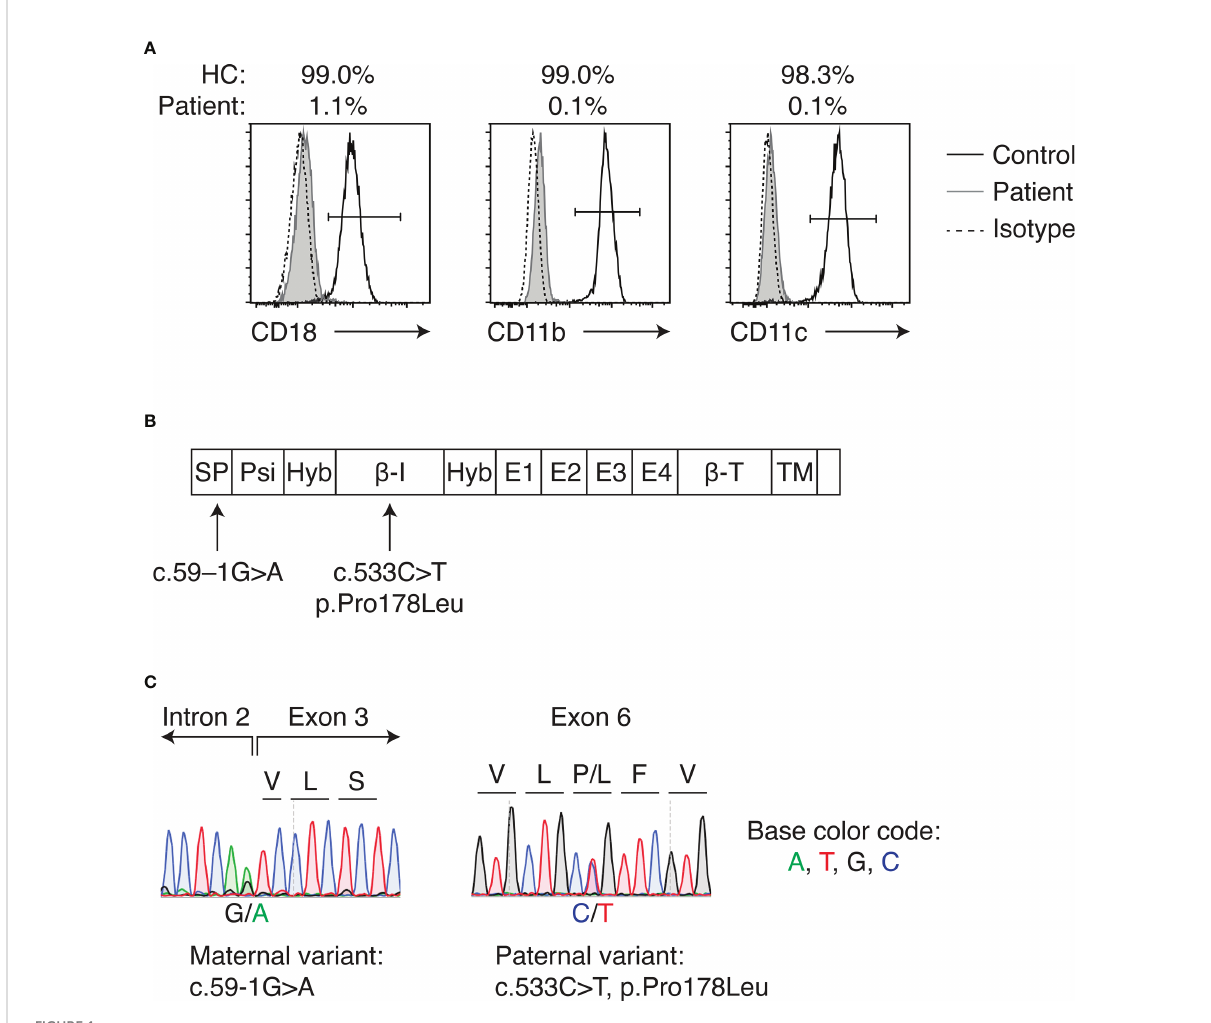
FIGURE 1 LAD-I diagnosis in the patient. (A) Flow cytometric analysis of CD18, CD11b, and CD11c expression on peripheral blood neutrophils of the patient and healthy control. Percentages above the plots indicate the percent positive cells for each molecule, as gated by the bars in each plot. (B) Domains of CD18 and locations of the variants detected in the patient. (C) Sanger sequencing of identi fi ed ITGB2 variants. Letters above the plot indicate amino acids. HC, healthy control; SP, signal peptide; Psi, plexin-semaphorin-integrin; Hyb, hybrid; b -I, I-like; E, integrin epidermal growth factor; b -T, b -tail; TM,